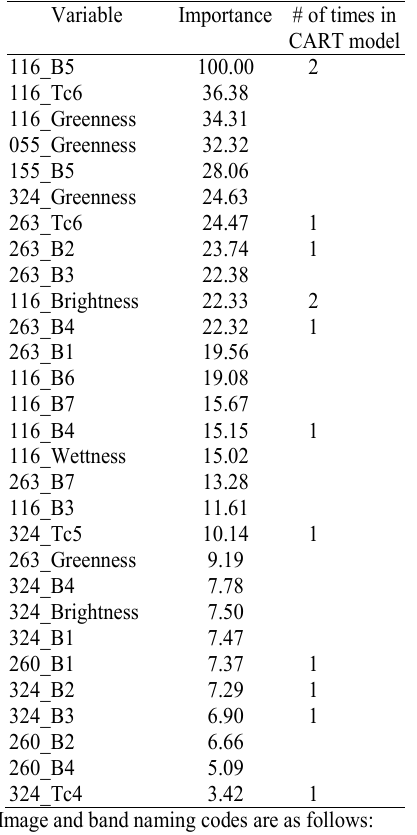
Table 5. Variable importance for the binary autumn olive